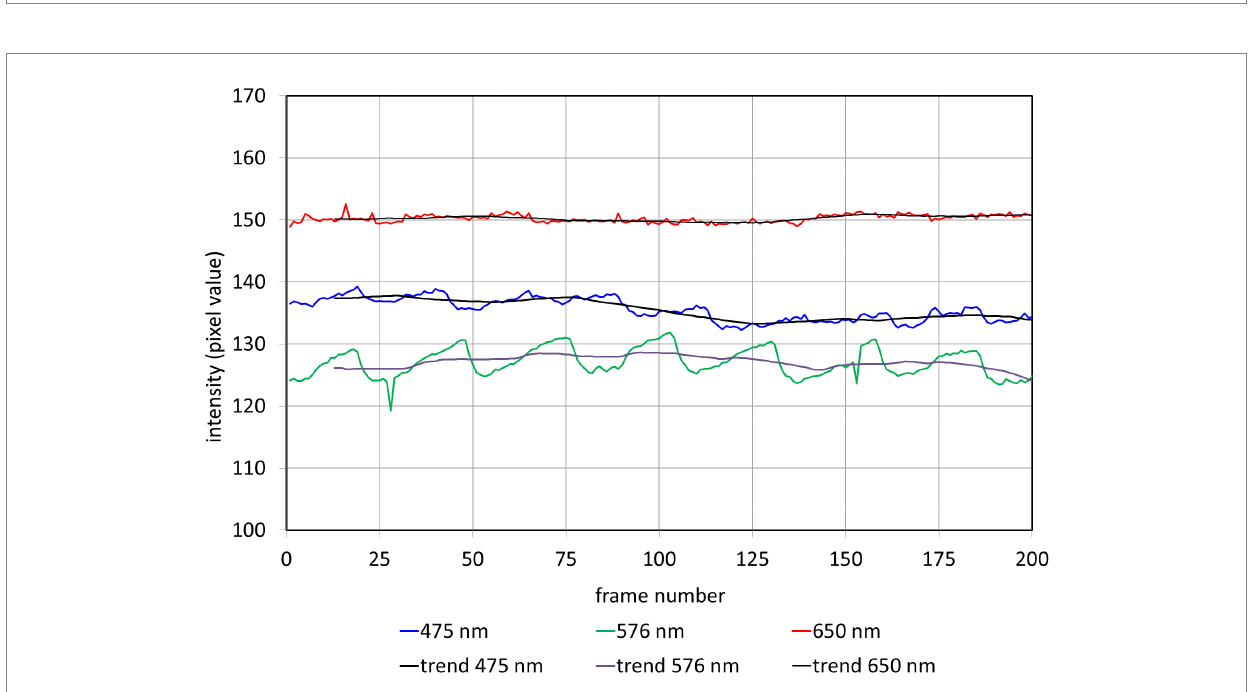
FIGURE 3 Intensity I raw ( 𝑛 ) and trend I avg ( 𝑛 ) in the selected AOI (see Figure 2) for different wavelengths. n: frame number.